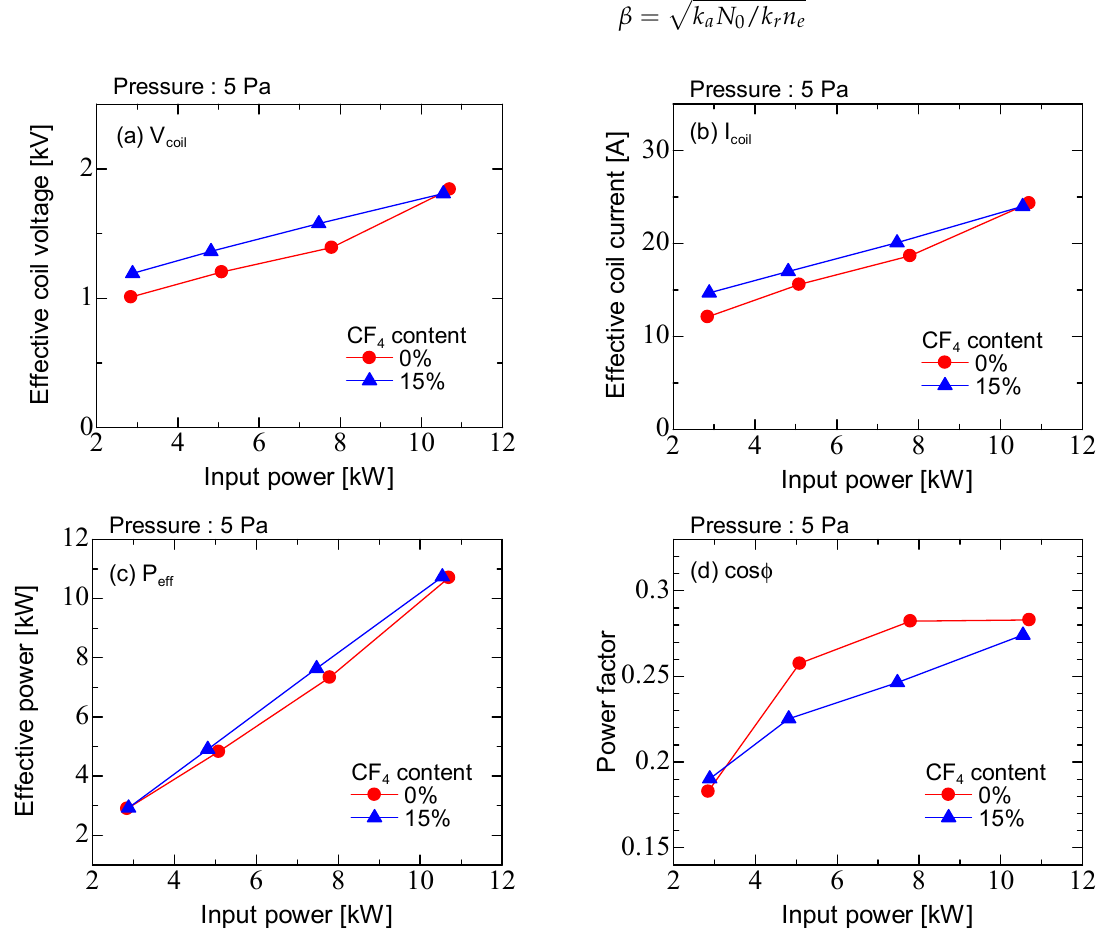
Figure 4. Electrical characteristics of the ICP as a function of input power for Ar discharge and Ar/CF 4 discharge. ( a ) Effective coil voltage, ( b ) effective coil current, ( c ) effective power and ( d ) power factor.